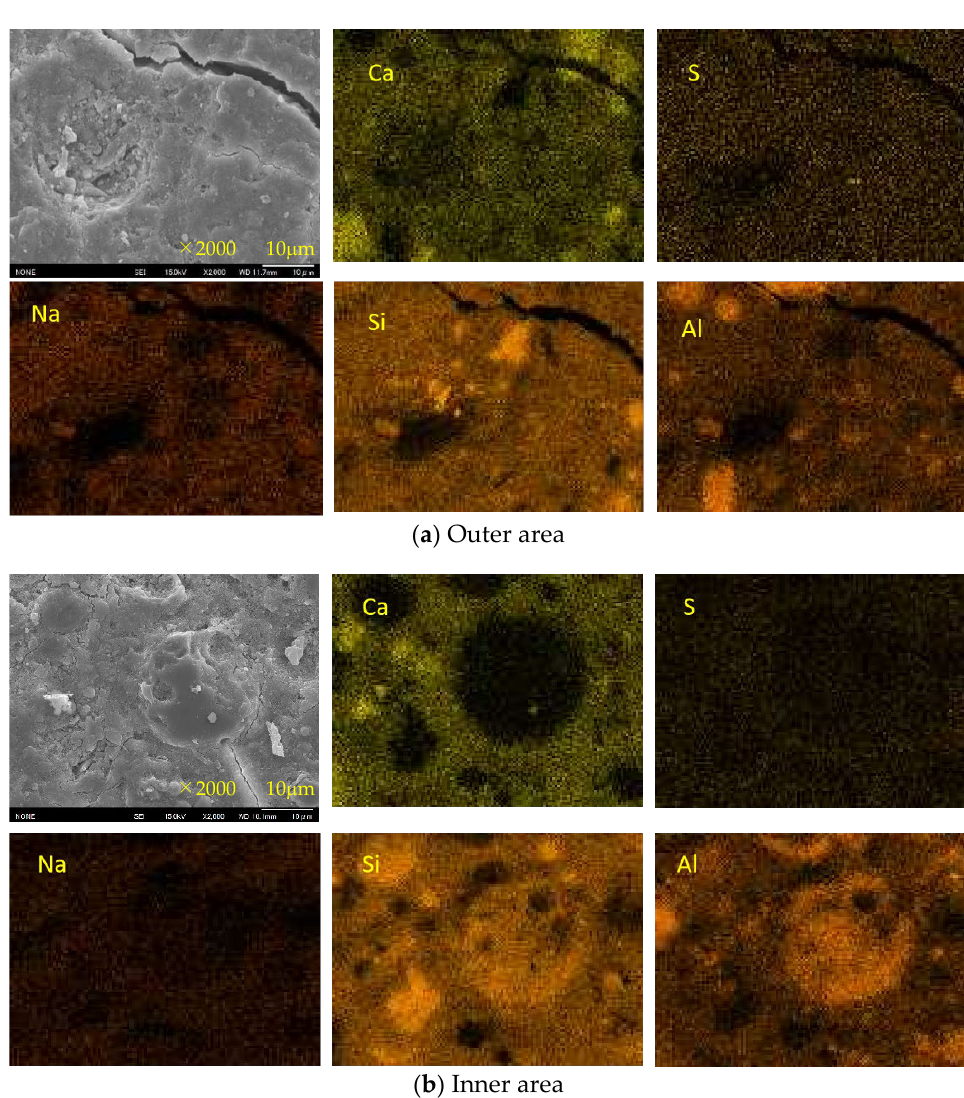
Figure 16. SEM images and element maps of the BFSCSP specimen.